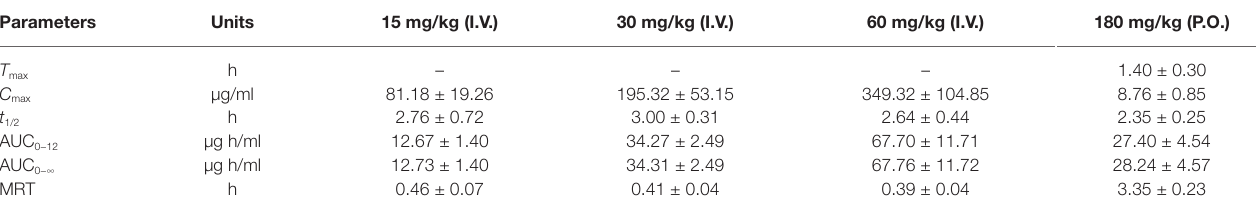
TABLE 1 | Pharmacokinetic parameters of sodium danshensu in rats after intravenous administration of 15, 30, and 60 mg/kg and oral of 180 mg/kg ( n = 6). Parameters Units 15 mg/kg (I.V.) 30 mg/kg (I.V.) 60 mg/kg